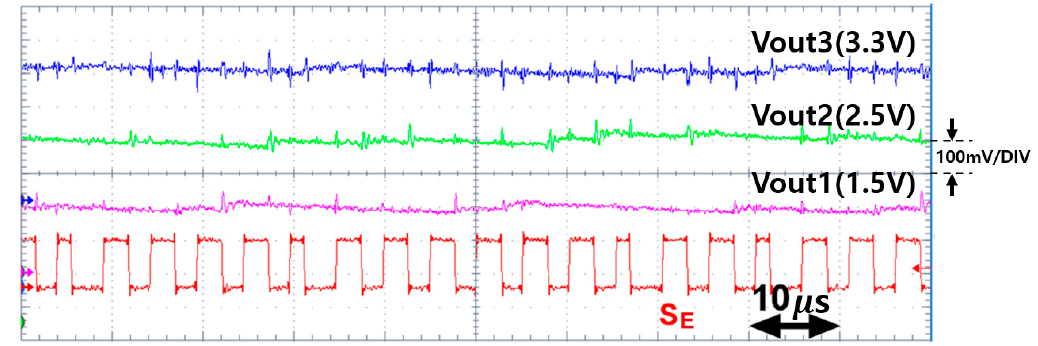
Figure 12. Measured waveforms of output voltages and gate-drive signal on switch S E while the sampled is sensed to be between and where = 2 V, = 100 mA, = 104 mA, and = 53 mA. Table 2. Specifications and component values of the proposed converter.